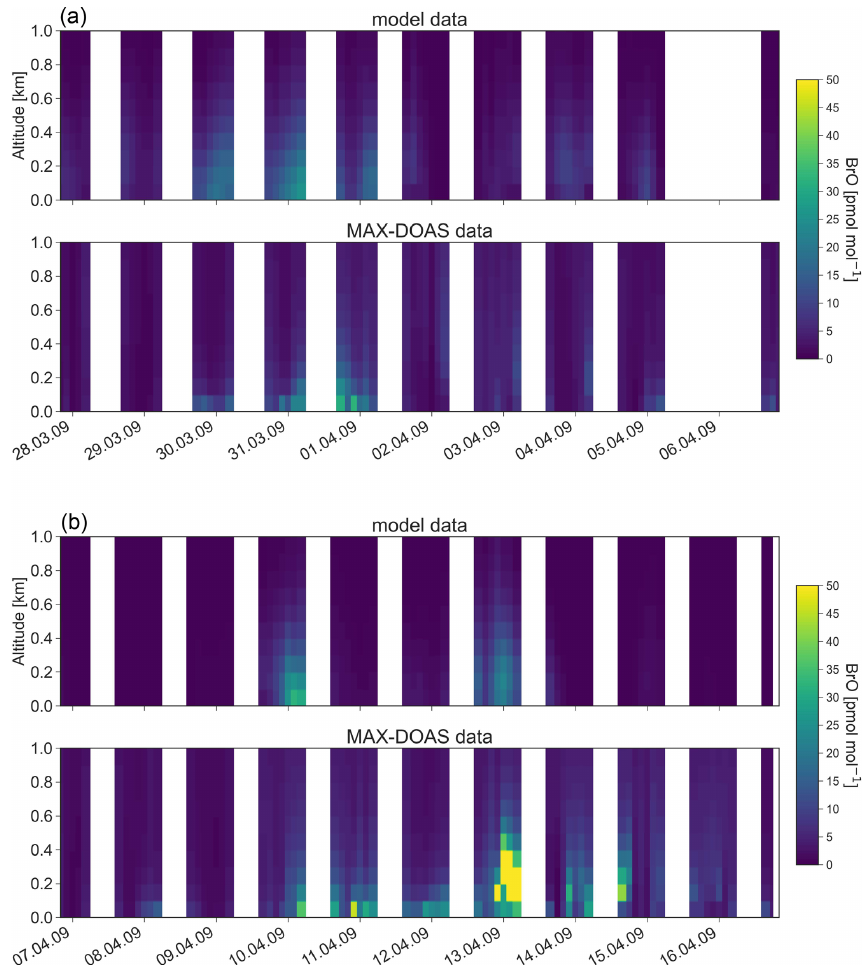
Figure 10. Vertical profiles of BrO from 28 March to 16 April 16 2009 at Utqia˙gvik. The data are shown at 00:00GMT − 9 (LT at Utqia˙gvik). (a) Modeled BrO convoluted with the MAX-DOAS averaging kernel; (b) BrO observed with MAX-DOAS.